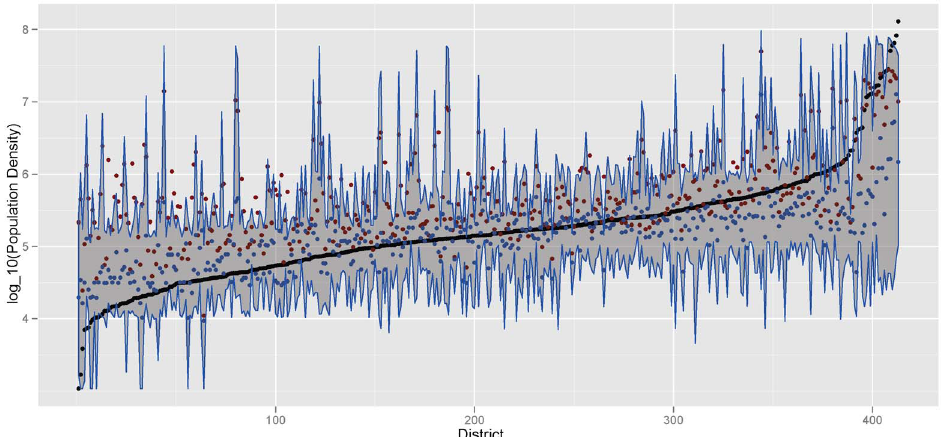
Figure 5. Random Forest uncertainty analysis. Observations of district population density (black points) are ordered from lowest to highest density. The Random Forest mean (red point), median (blue point) and interval between the 5 th /95 th percentiles (blue lines) illustrate the uncertainty in each corresponding model estimate.